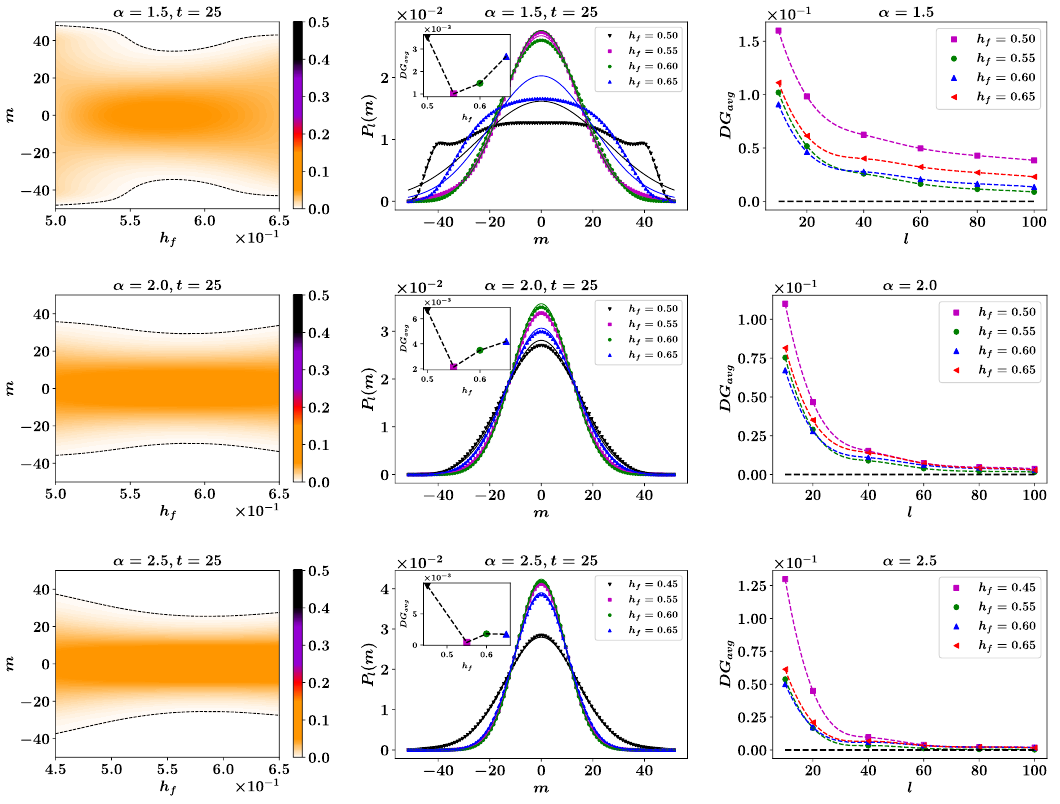
Figure 6: PDF dynamics of subsystem magnetization after a quantum quench as a function of post quench transverse field h at three representative values of interac- f tion range α = { 1.5,2.0,2.5 } . The dotted lines are the lines of constant probability at P ( m ) = 0.002, these lines don’t have any quantitative significance and is plotted for better visualization of PDF. The first column shows the color plot of PDF at time t = 25 at different values of h and l = 100. The second column shows the PDF f at t = 25 at different h , the symbols are the TDVP calculations whereas the lines f are the Gaussian approximation 10. The inset shows DG at corresponding values avg of h . The last column shows the finite size dependence of DG for four differ- f avg (cid:128) (cid:138) th 3 ent values of h . DG is calculated by averaging over the final of the total f avg 5 simulation